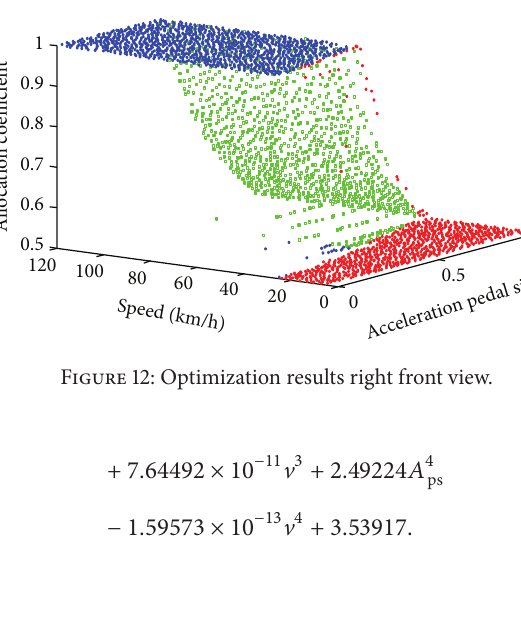
Figure 11: Optimization results side view.